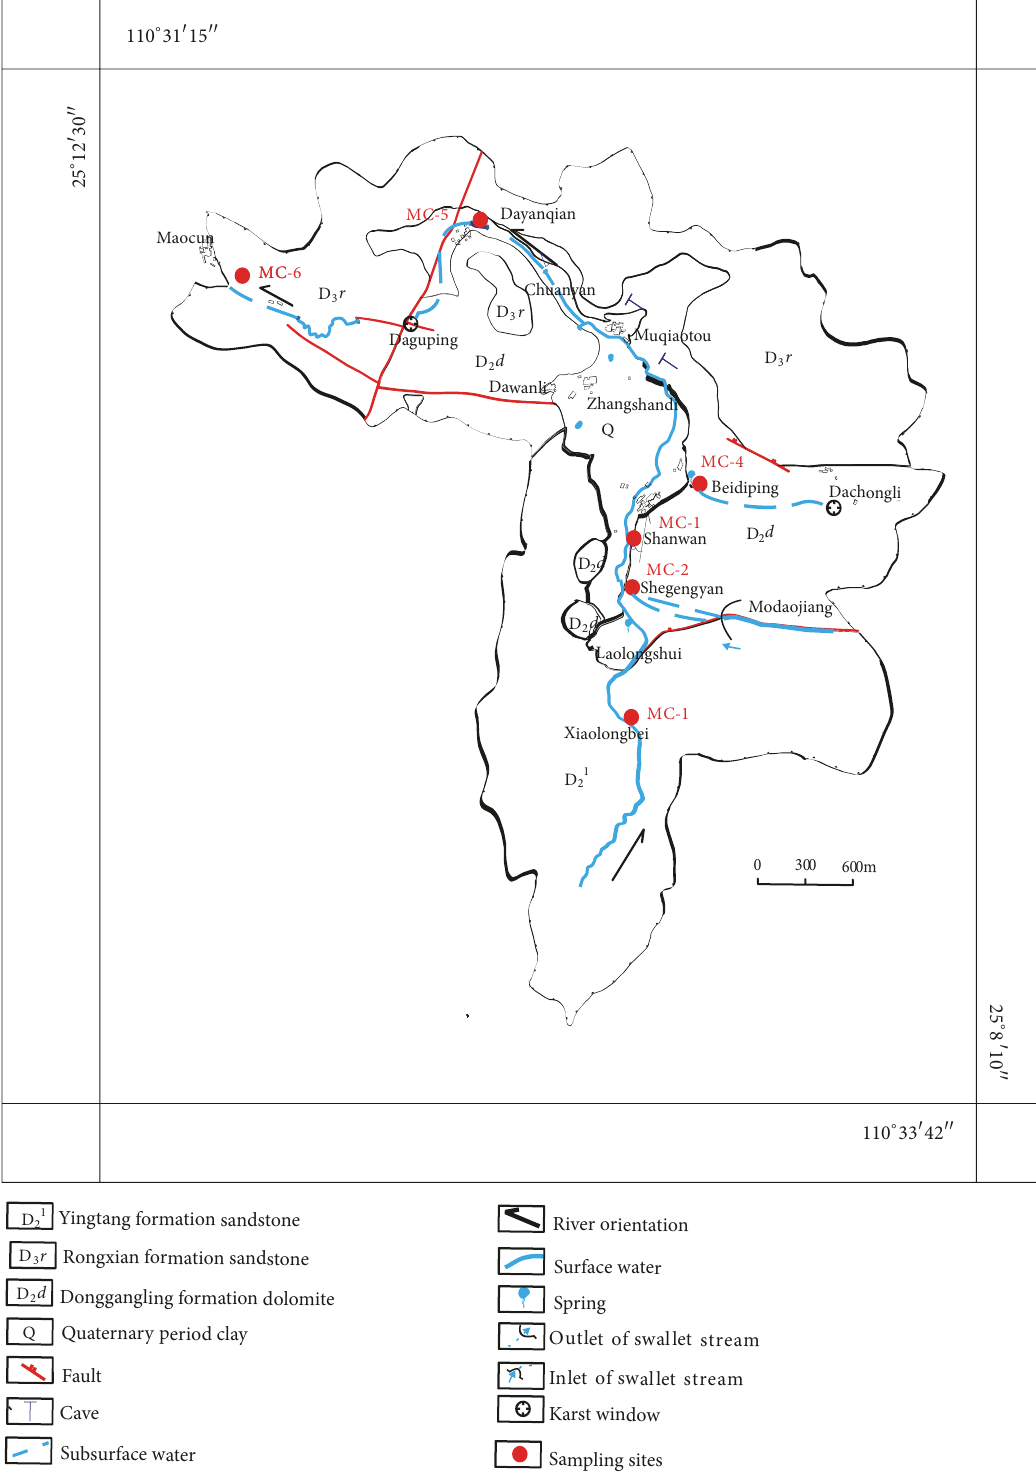
Figure 4: Hydrogeological map and location of sampling sites in the Maocun subterranean river